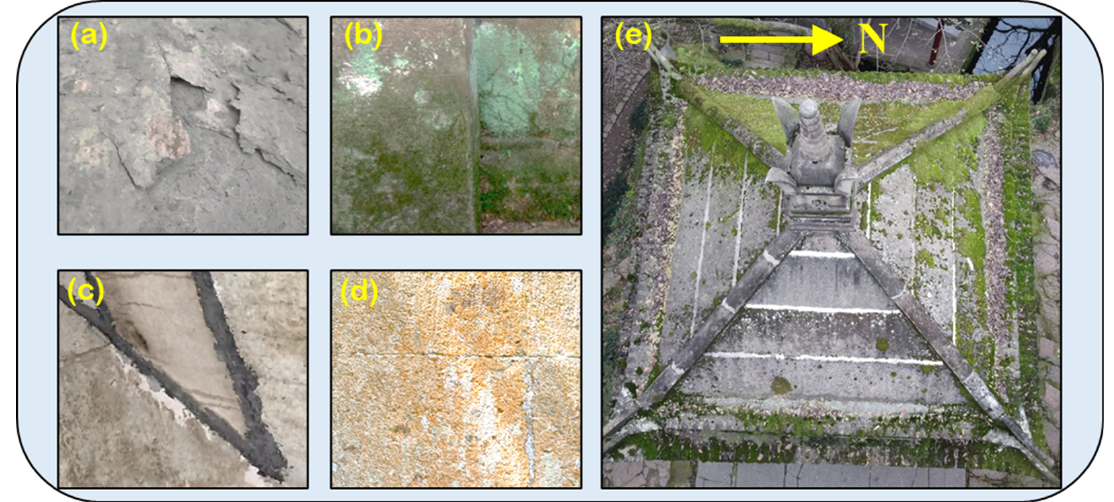
Figure 4. Typical images of surface weathering diseases of the stone house ( a ) detachment; ( b ) biological colonization; ( c ) improper repair; ( d ) discoloration; ( e ) top view of the stone house.